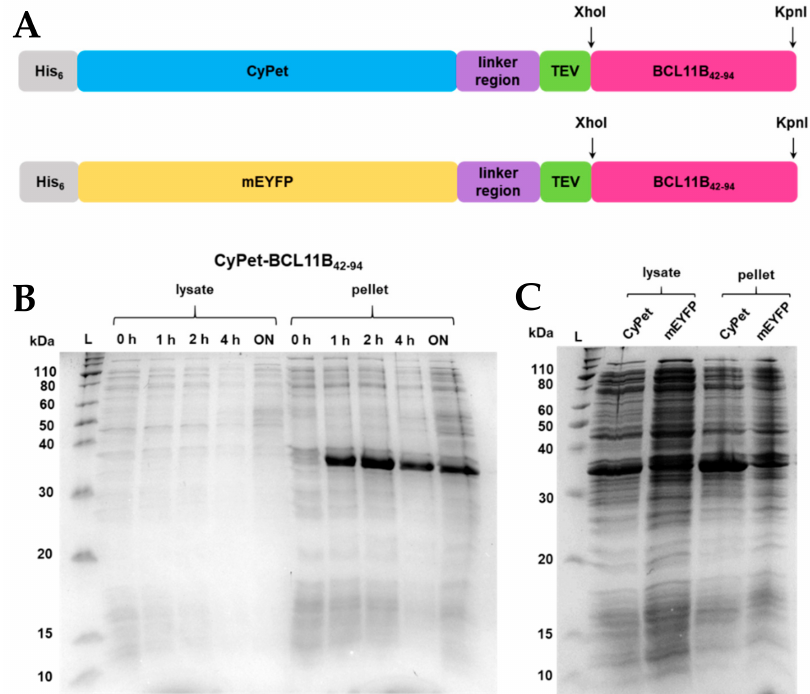
Figure 1. ( A ) BCL11B 42-94 fusion protein sequence showing an N-terminal His 6 -tag, fluorescent CyPet, and mEYFP protein tag, respectively, a flexible linker region, a TEV-cleaving site, enzyme restriction sites XhoI and KpnI, and the BCL11B 42-94 zinc finger domain. The BCL11B 42-94 domain has a size of 5.5 kDa, and the full-length fluorescent fusion proteins have a size of 36 kDa each. ( B ) SDS-PAGE showing expression trials of CyPet- and mEYFP-BCL11B 42-94 in E. coli NiCo21 grown in TB medium at 37 ◦ C at different time points or ( C ) at 16 ◦ C overnight. For comparative reasons, all E. coli cultures were diluted to an OD 600 = 0.6 before lysis and loading the